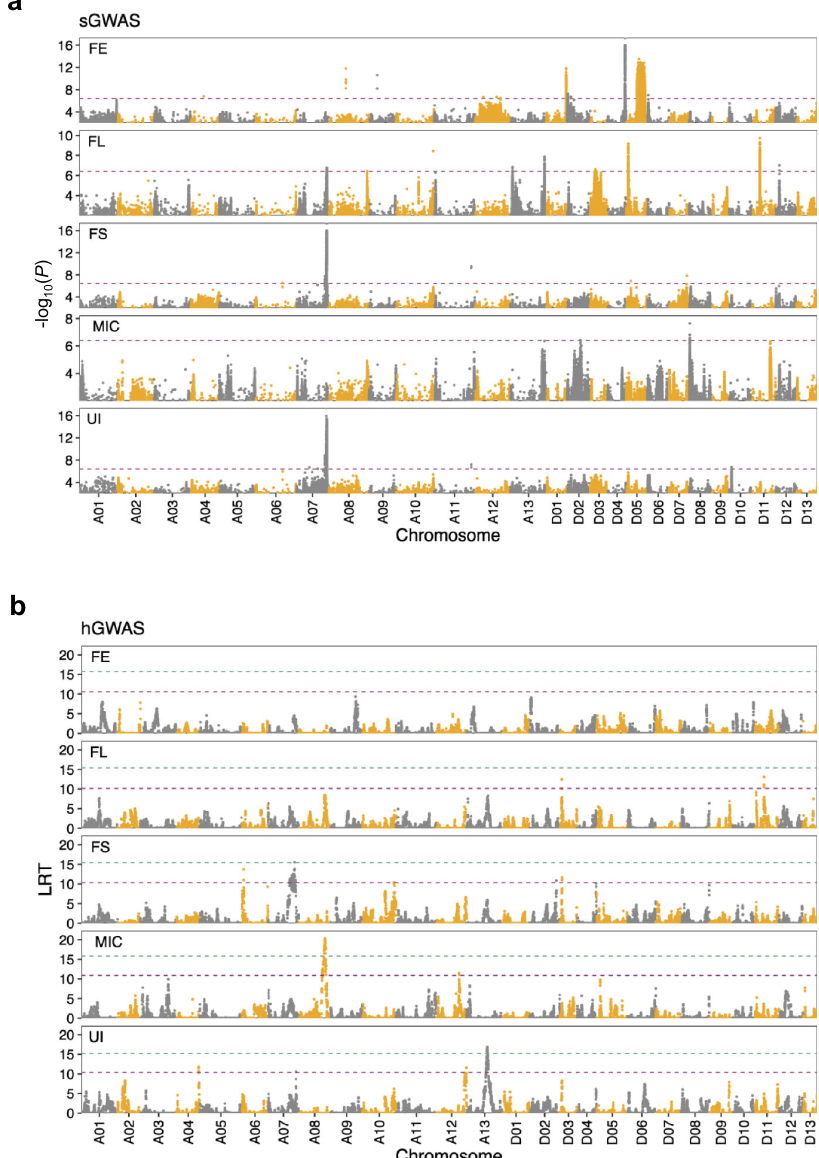
Fig. 3 Manhattan plots for fi ve fi ber-quality traits based on two different GWAS methods. a SNP-based GWAS (sGWAS). Purple line represents the signi fi cant threshold ( − log 10 P = 6.43). b IBD-based GWAS (hGWAS). Green line and purple line represent signi fi cant and suggestive thresholds. The 95th and 37th percentile of 100 permuted LRT scores were used as the signi fi cance threshold (LRT = 15.76, 15.14, 15.43, 15.83, 15.44) and suggestive threshold (LRT = 10.55, 10.39, 10.35, 10.92, 10.14), respectively. The fi ber traits include elongation (FE), length (FL), strength (FS), micronaire value (MIC), and uniformity